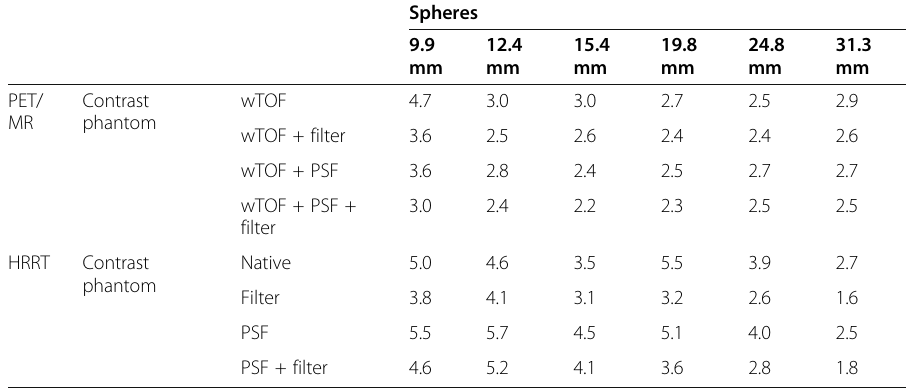
Table 6 %BG variability for the contrast phantom scanned on the PET/MR and HRRT